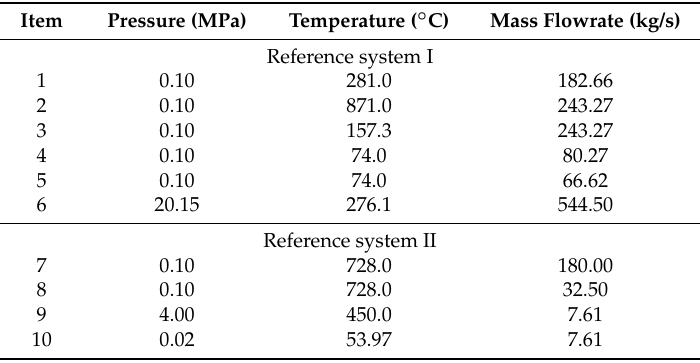
Table 7. Main stream parameters of the reference